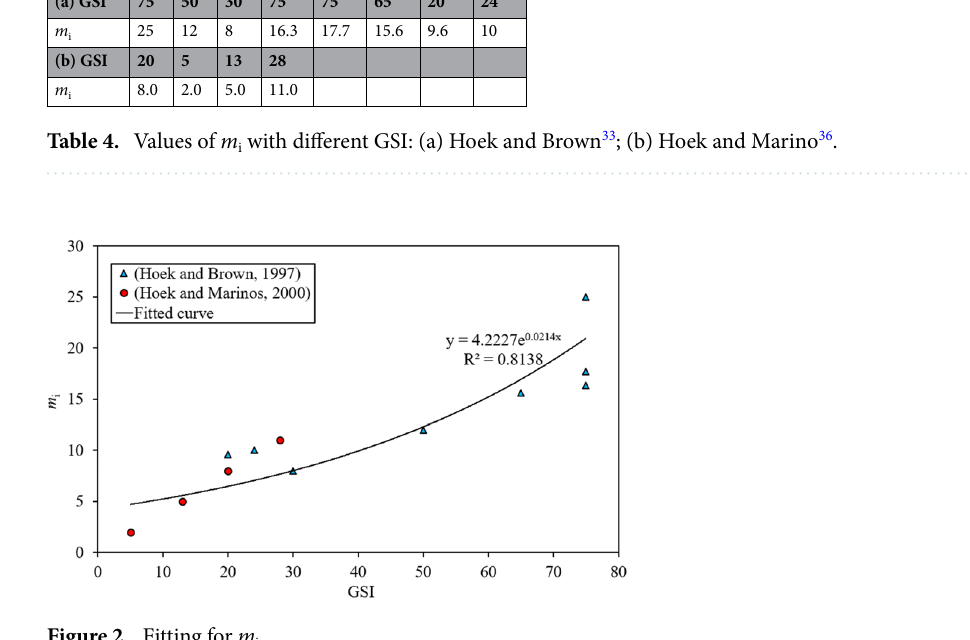
Figure 2. Fitting for m i